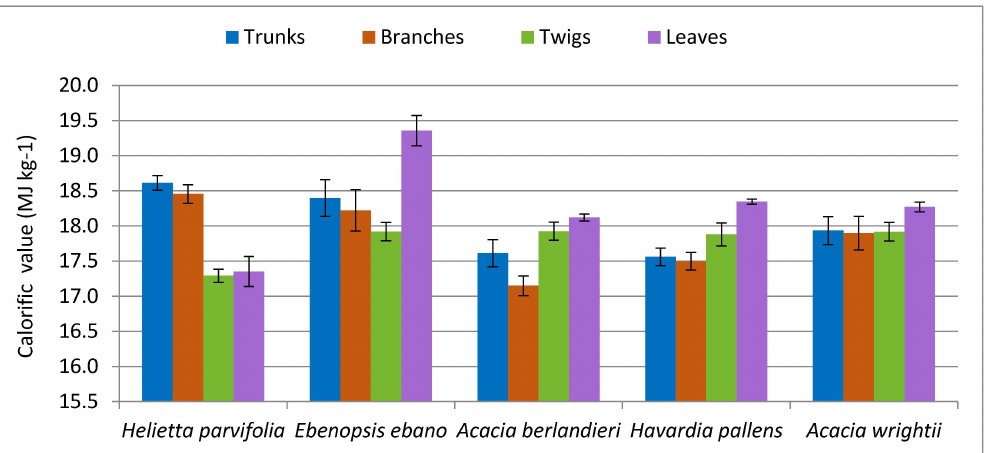
Figure 1. Calorific value of five planted timber species of the semi-arid land of Mexico, in different biomass